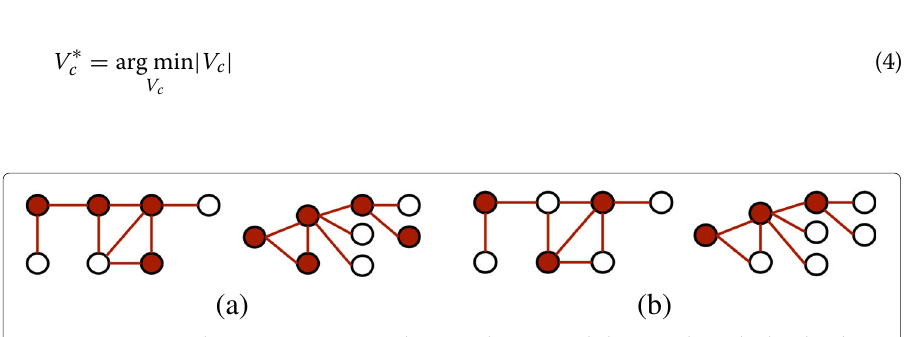
Fig. 3 Vertex cover and minimum vertex cover shown on the same underlying graphs. Red colored node indicates the node in the cover because all edges are covered. a Vertex cover (not minimum). b Minimum vertex cover Figure